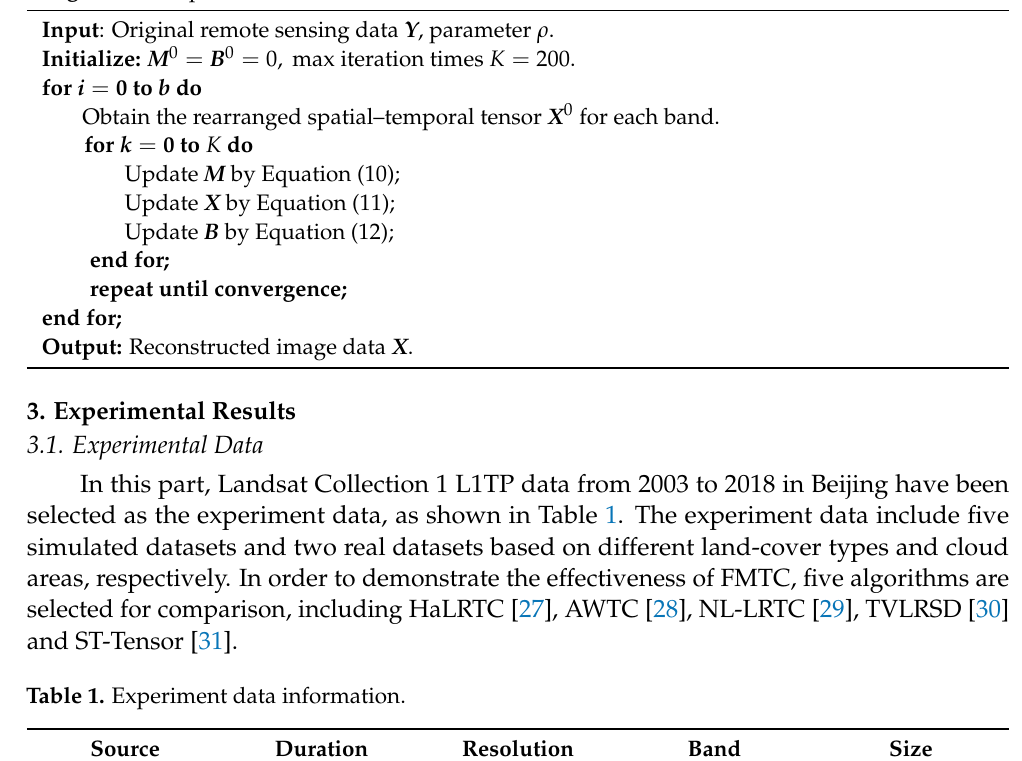
Algorithm 1 Optimization of the FMTC method